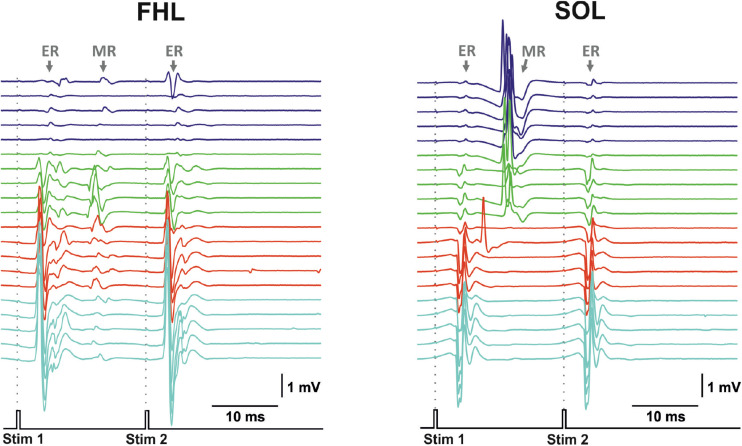
The representative examples of evoked potential dynamics with increasing current for transvertebral double-pulse electrical stimulation (1,900–2,200 μA) delivered at VL5 vertebrae for mm. flexor hallucis longus (FHL) and soleus (SOL). Stim, stimulation impulse; ER, early response; MR, medium response.